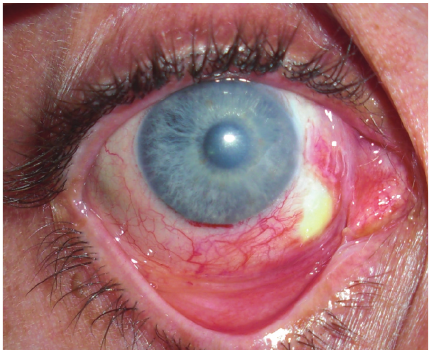
Figure 1: Limbal ischemia in the inferonasal quadrant 8 days after alkali burn. Patient subsequently underwent tenonplasty and conjunctival advancement to cover the defect.